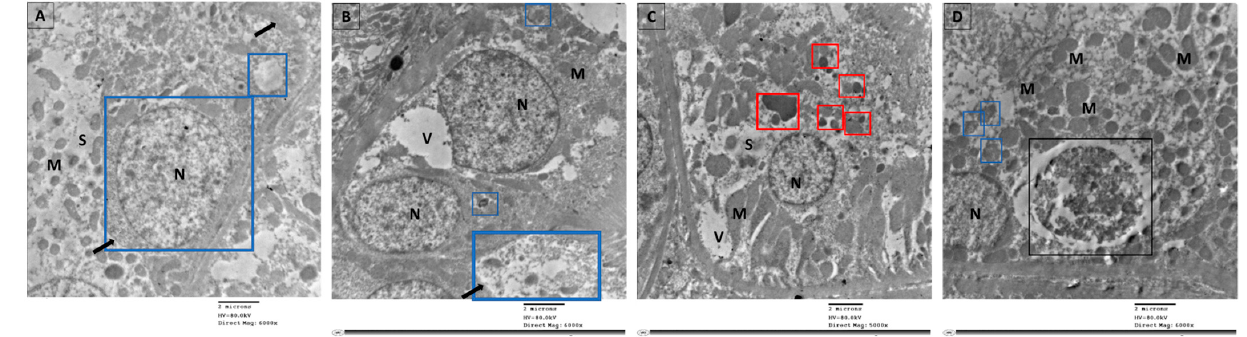
Figure 9. Selected micrographs by TEM of renal cells in the fasting group exhibited the four sequential steps in the autophagy process which are initiation and formation of isolation membrane (blue square) in ( A ), formation of autophagosomes (blue square) in ( B ), fusion of autophagosome with lysosome (red square) in ( C ), and maturation of autophagosomes into autolysosomes (black square) in ( D ). Signs of apoptosis were absent as there were no apoptotic bodies nor chromatin condensed at the periphery of the nucleus (N). In addition, newly formed mitochondria (M) were numerous, cytoplasmic space (S) were mostly in ( A ), and vacuoles (V) were observed in ( A , B ), while in ( C ) the cytoplasmic space (S) and the vacuoles (V) were less abundant.